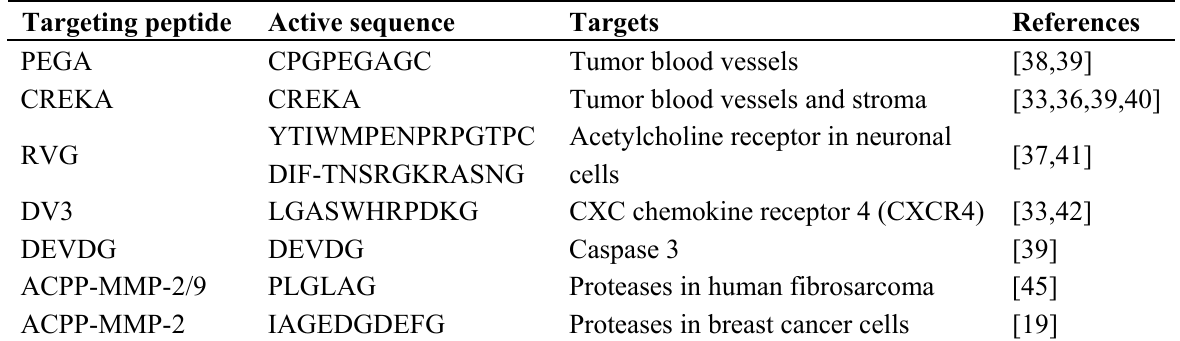
Table 2. Examples of targeting sequences coupled to CPPs for specific delivery to tumors or tissues. Targeting